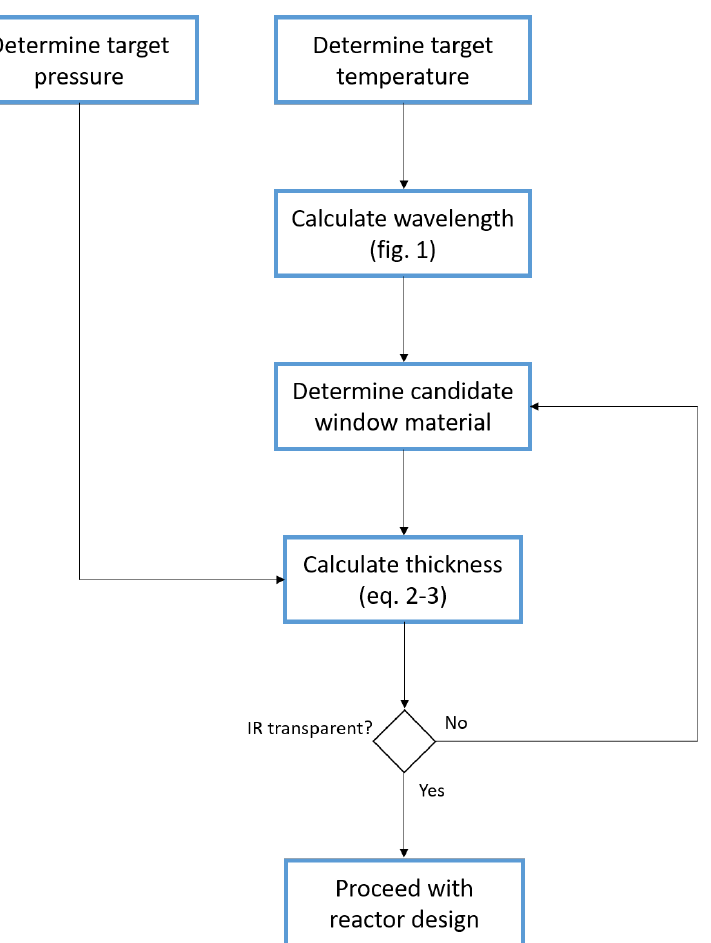
Figure 4. Decision tree for the determination of the appropriate material for the IR cell. Table 2. Properties of various IR transmitting materials (transmitting wavelength elaborated from [32], transmission at 8 and 4 μm as well as melting temperature are elaborated from [33]).